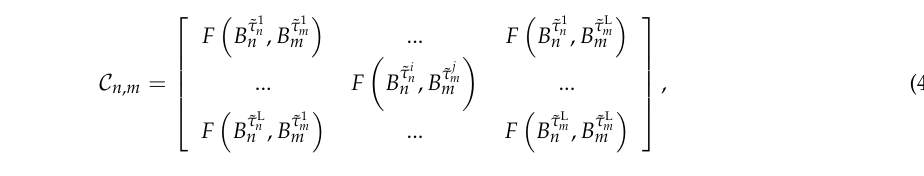
j i 1 2 ; ( c ) the ZF detector B ˜ τ ; 2 1